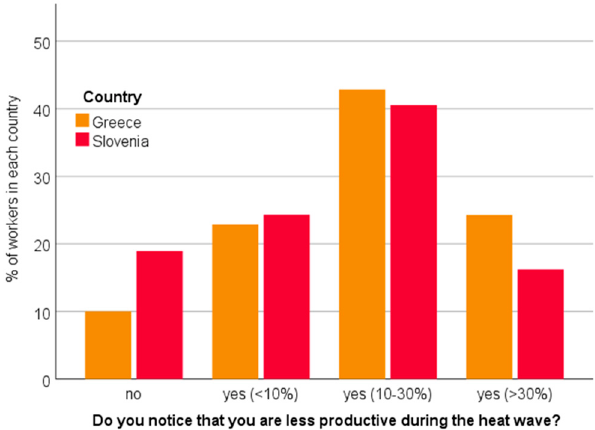
Figure 5. Workers’ assessment of their reduced productivity due to heat stress during heat waves. On the other hand, more Greek workers (24%, in Slovenia 16%; p > 0.05) assessed the loss of